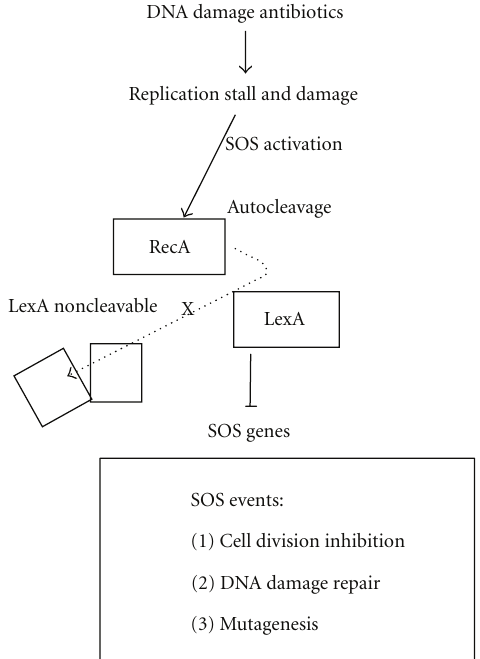
Figure 1: The bacterial SOS response. The response is triggered by DNA-damage antibiotics. This response is controlled by the RecA-LexA interplay, in which LexA represses the SOS genes. DNA damage activates RecA to simulate autocatalytic cleavage of LexA so that the SOS genes are depressed and expressed. X, the mutation rendering LexA